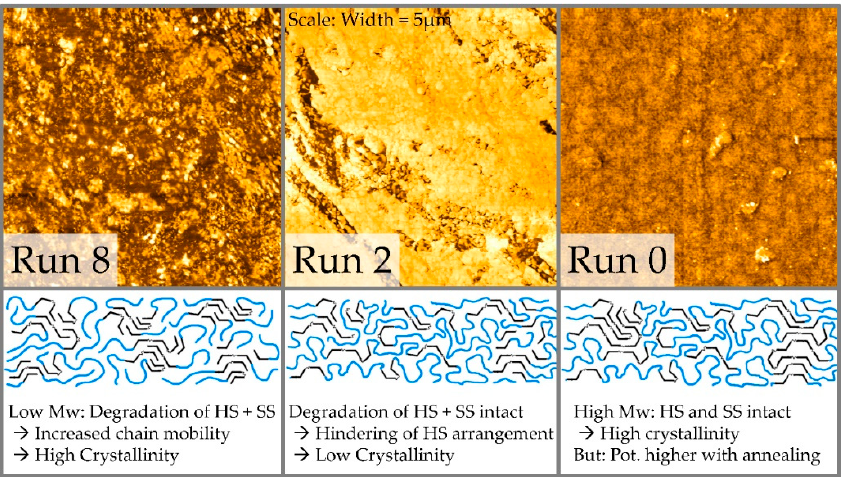
Figure 7. AFM pictures of the morphology of virgin (R0), two times recycled (R2) and 8 times recycled (R8) TPU together with possible hard segment (HS)- and soft segment (SS)-structures. The sides of each image have a length of 5 µm.